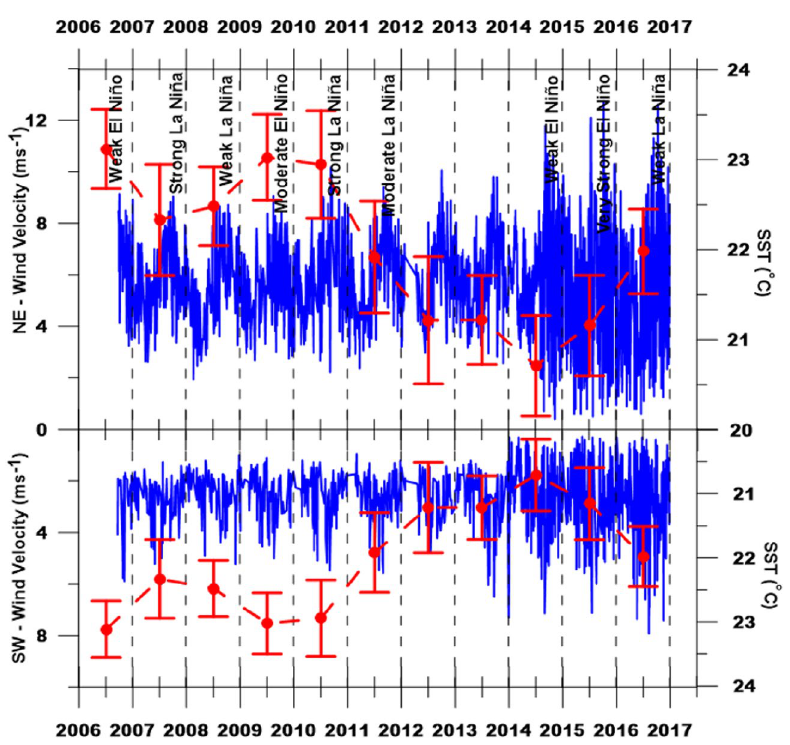
Figure 5. Wind velocity at quadrants SW and NE (blue line) with the respective variation of sea surface temperature (SST) at the Cabo Frio/RJ upwelling area (circle with a vertical bar in red), showing the average temperature and the standard deviation between 09/2006 and 12/2016, according to mild (Weak), and moderate to strong (Mod. to Str.) El Niño and La Niña